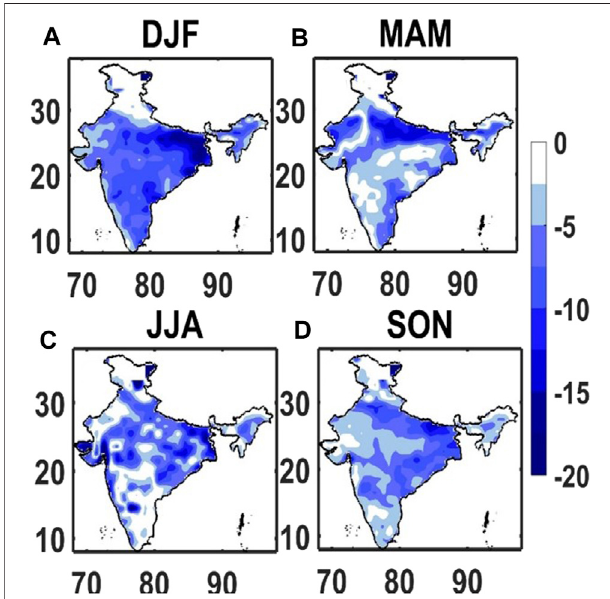
FIGURE7| Variation ofARFdifference(BOA) overIndian region(W ° m − 2 ) for (A) Winter (DJF), (B) Pre-monsoon (MAM), (C) Monsoon (JJA), and (D) Post-monsoon (SON) using minimum ARFE.